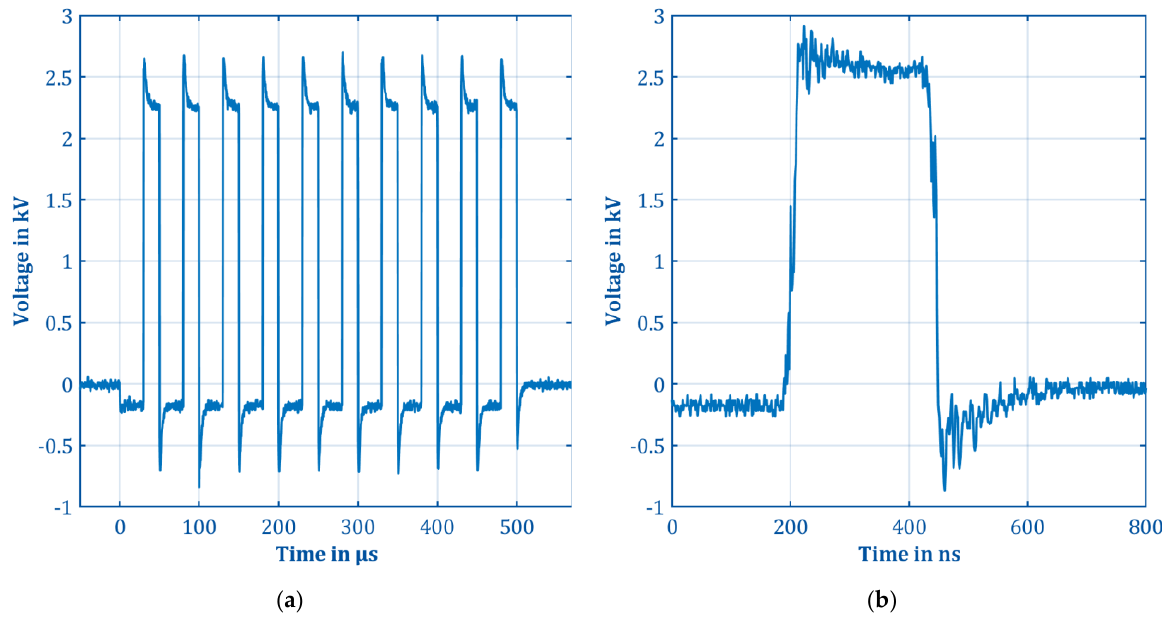
Figure 15. ( a ) Bursts of ten high-voltage pulses with a width of 40 µs measured with the developed resistive voltage divider, and ( b ) one single 250 ns wide high-voltage